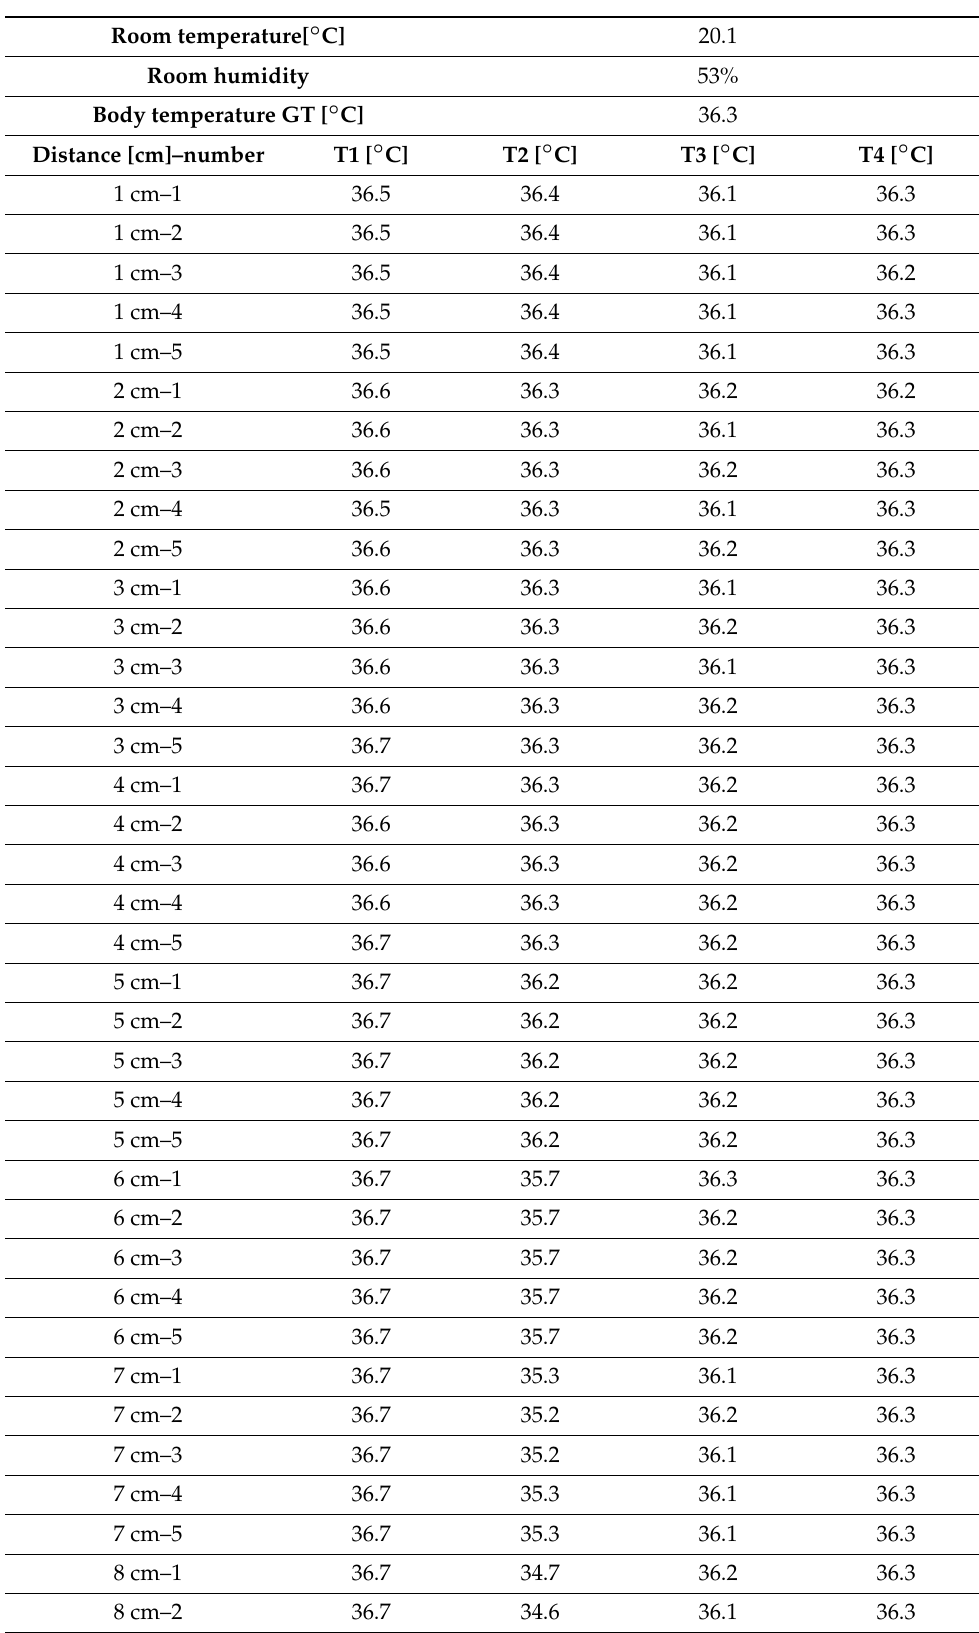
Table A4. Body–device distance experiment. Subject 1 body temperature